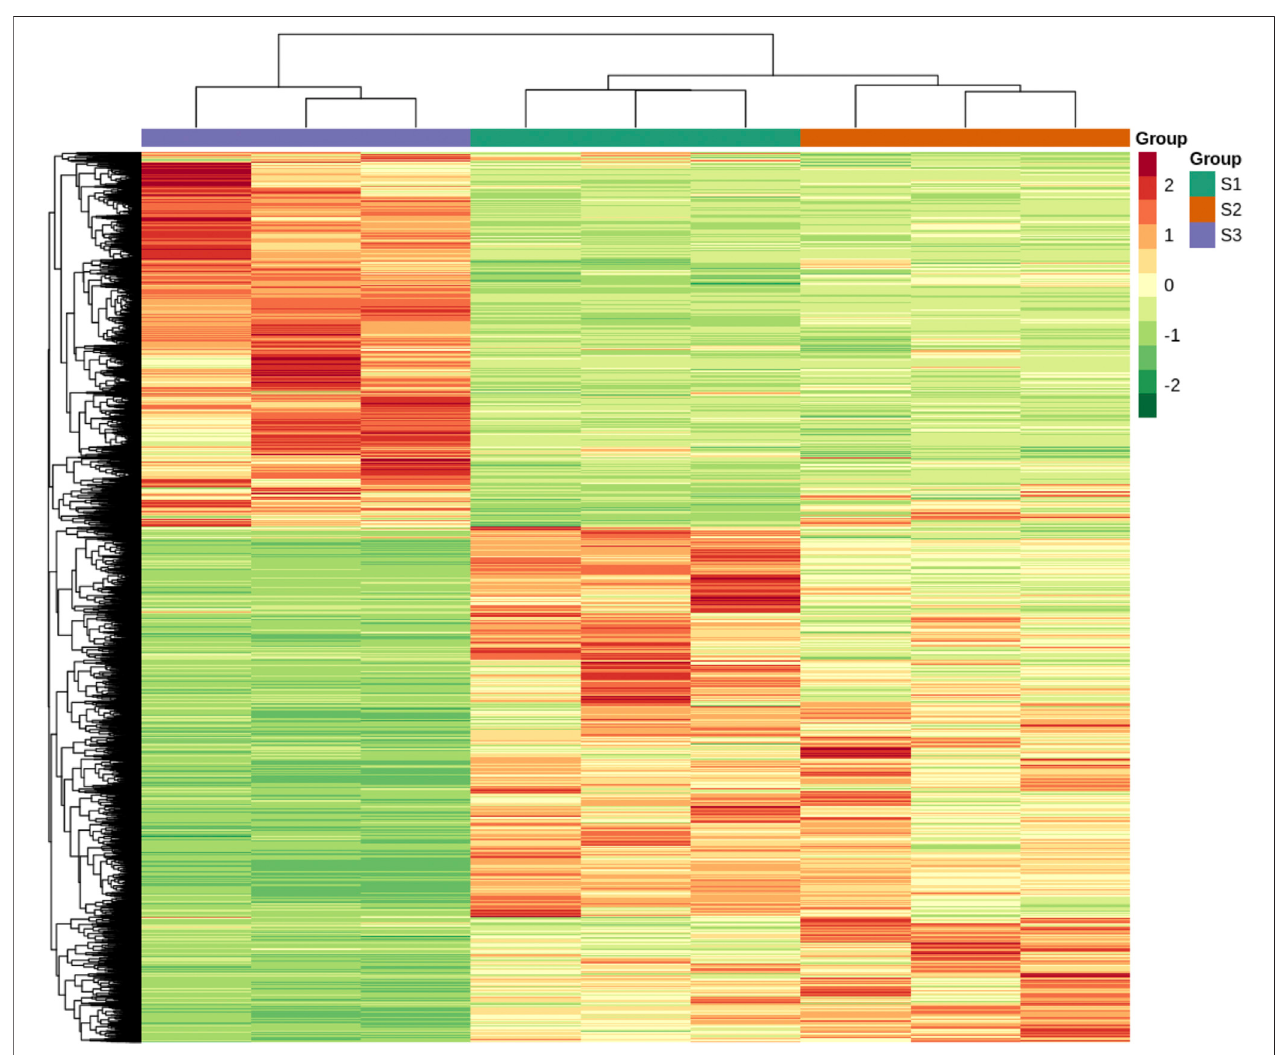
FIGURE 6 | All DEGs expression heatmap at three developmental stages of M. ternifolia nutshell.